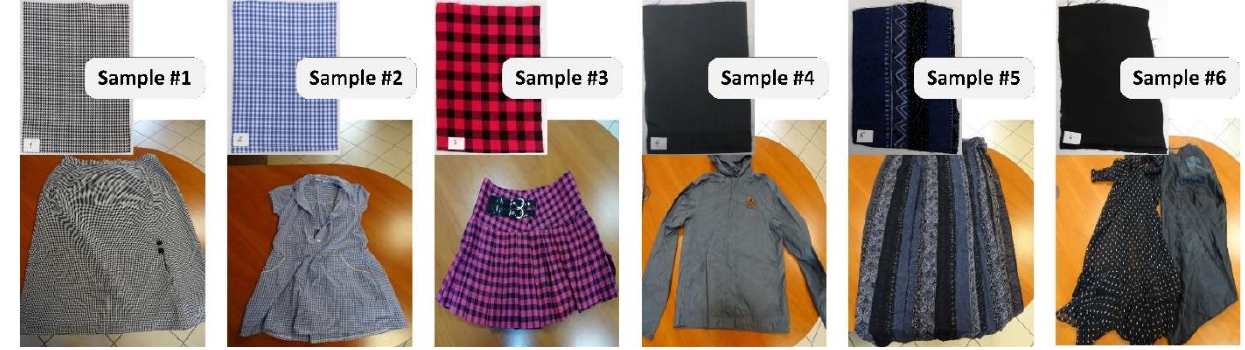
Figure 3. Test samples of the preliminary experiment.